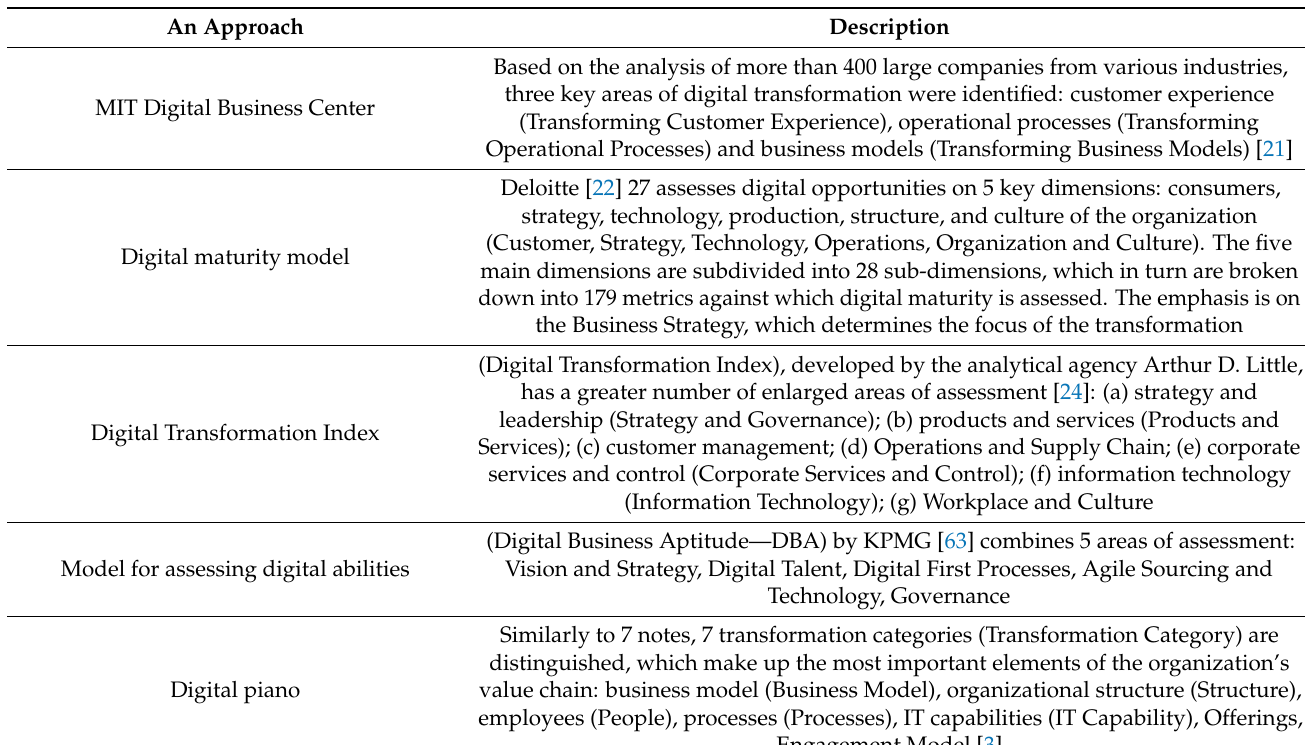
Table 5. Approaches to the study of the level of readiness of digitalization of objects